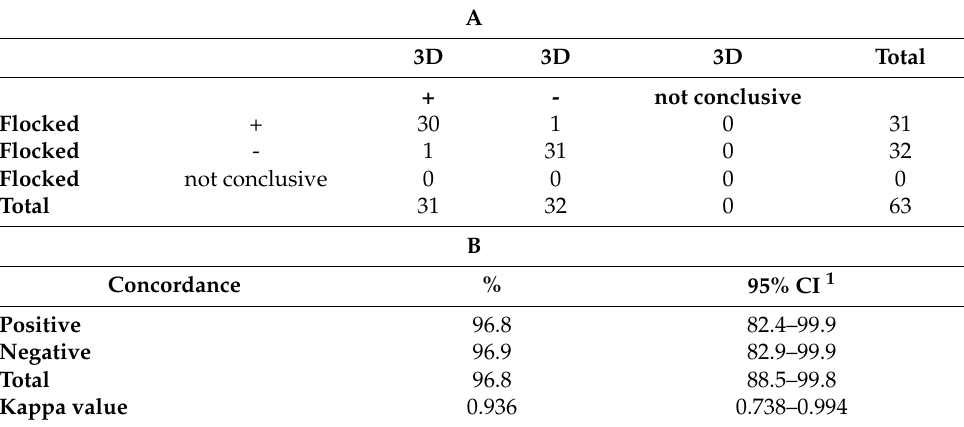
Table 2. Tables of agreement between flocked and 3D-printed swabs showing positive and negative concordance percentages with Kappa values ( A ) and total number of positive (+), negative (-), and inconclusive (IC) PCR results ( B